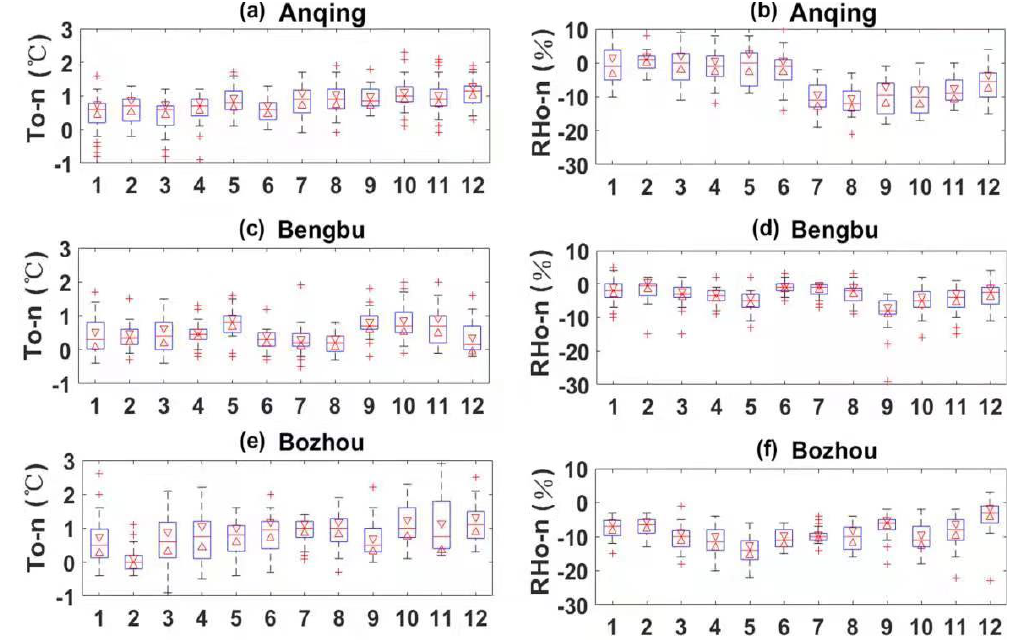
Figure 11. Monthly difference in the daily mean temperature (left—hand panels) and relative humidity (right—hand panels) between the new and old stations (old station data minus new station). ( a , b ) Anqing (AQ), ( c , d ) Bengbu (BB) and ( e , f ) Bozhou (BZ) stations.